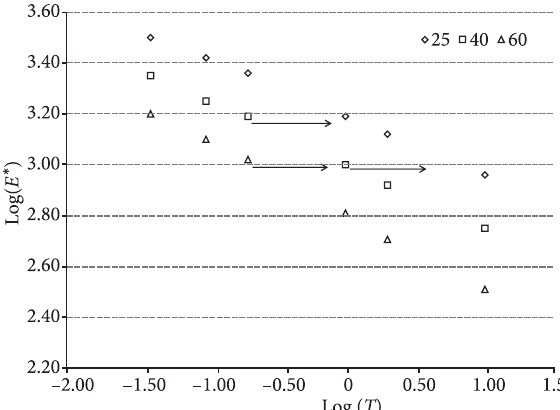
Fig. 8. Comparison of horizontal shift factors for SMA